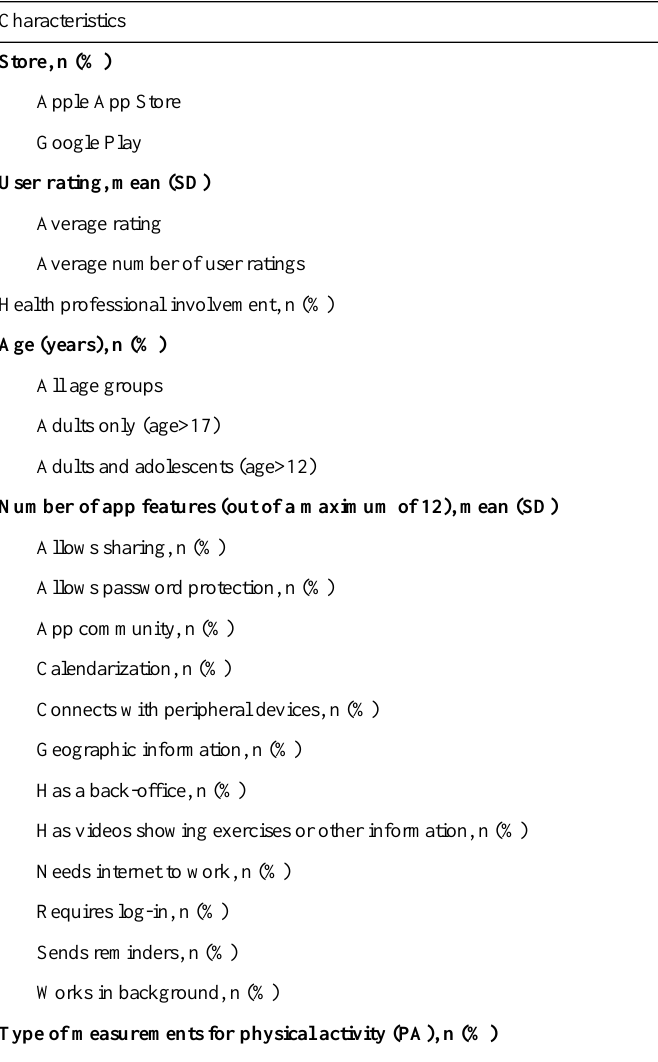
Table 1. General characteristics of the included apps